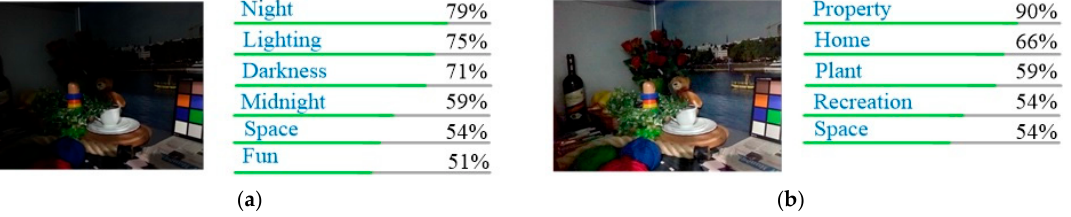
of low-light image; ( b ) Recognizing result of our enhanced image.